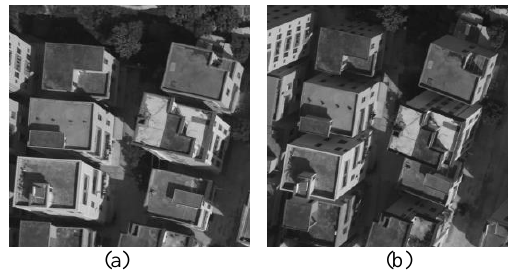
Figure 1. Low-altitude images with viewpoint change: (a) reference image. (b) test image.